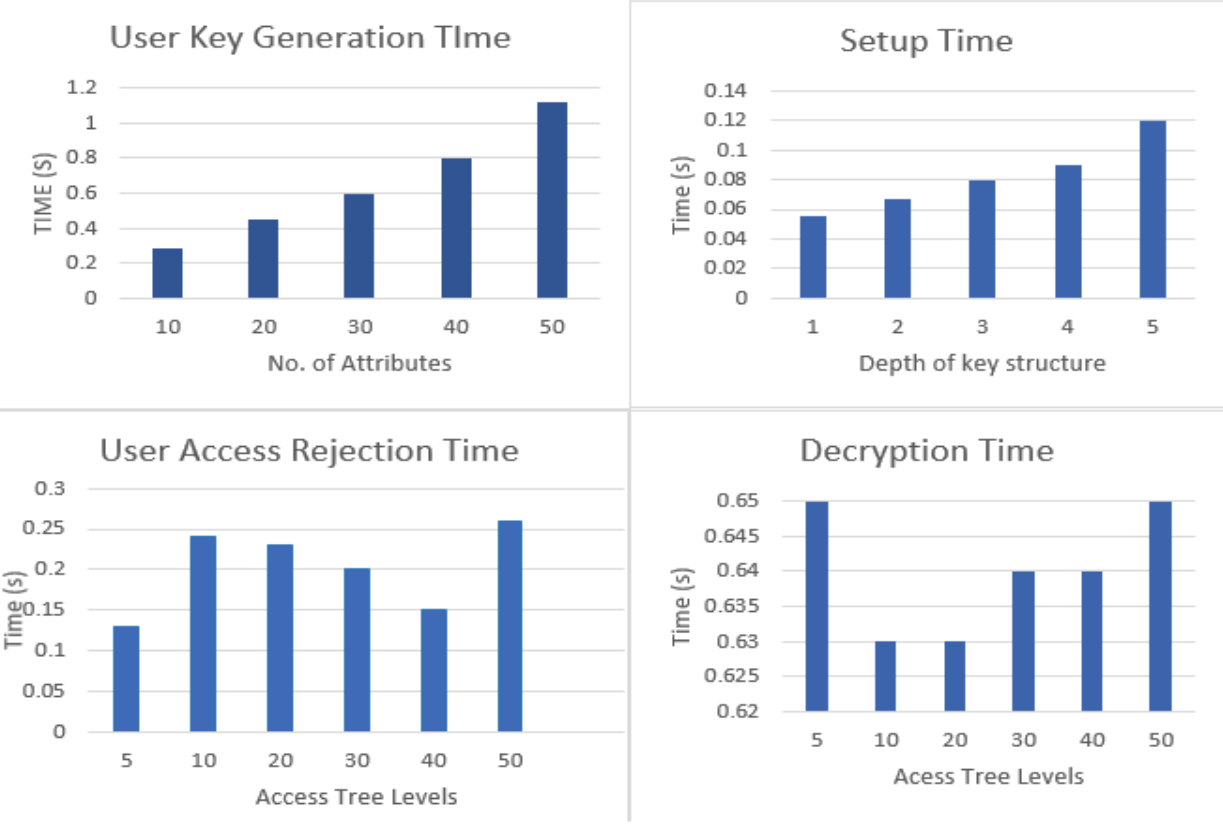
Figure 4 . Experiments on Computational complexity of system setup, key generation, decryption and, user access